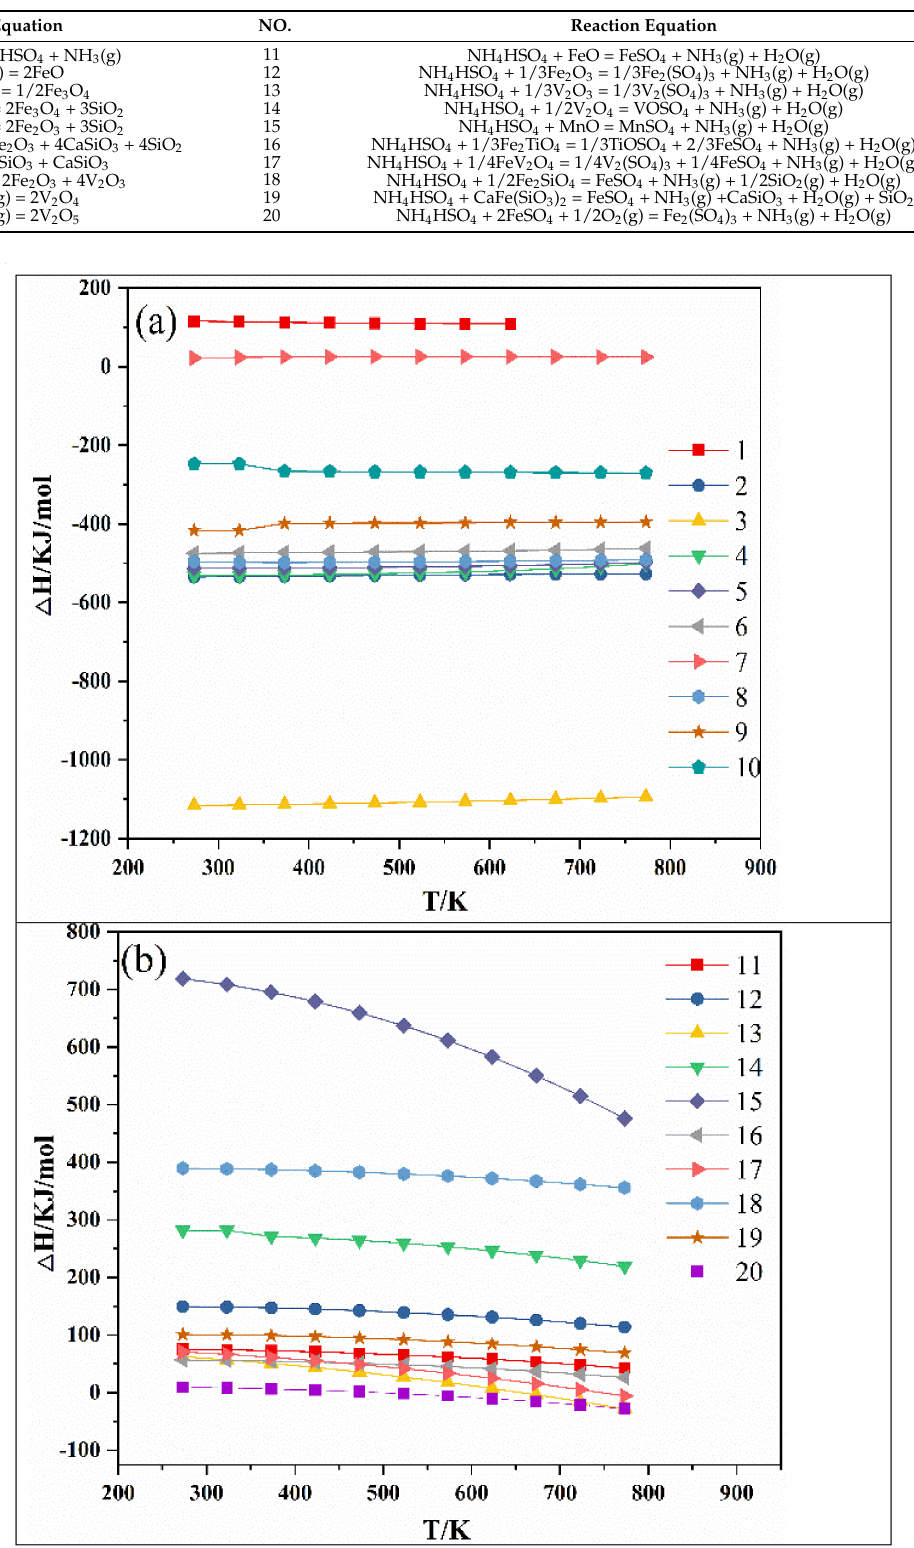
− T diagrams for the potential chemical reactions between vanadium slag and ABS Figure 1. ∆ H o T during the roasting process, where ( a ) shows the reactions 1 to 10, and ( b ) shows the reactions 11 to